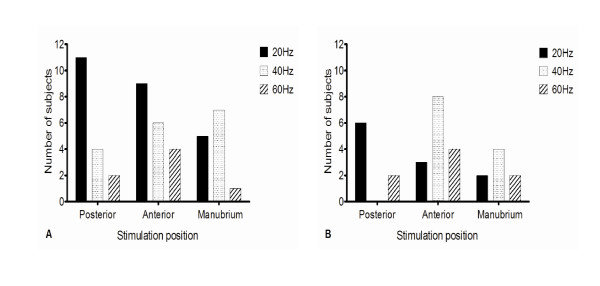
Threshold frequencies at which: a) two-cough responses. b) five-cough responses were induced in each stimulation position in patients with IPF.